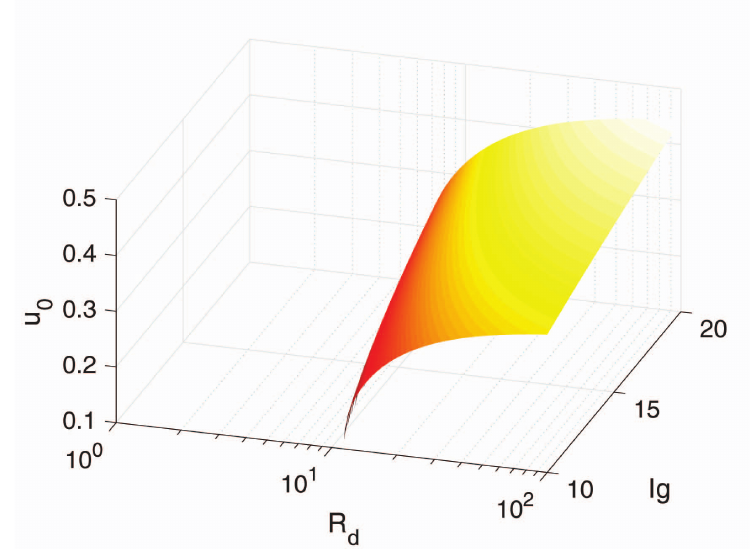
Figure 4. Variation of the equivalent control as R D and I gM vary. If low generator current is imposed and the load is high (the resistance is low), the solution may fail to